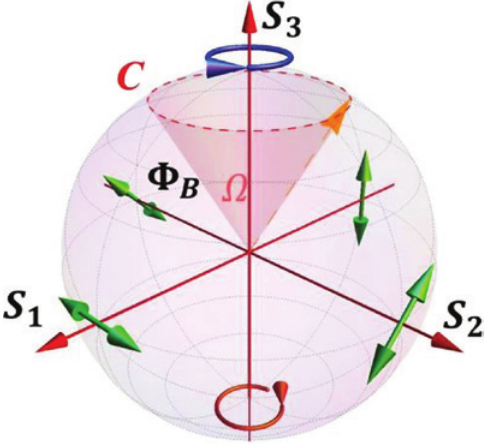
be characterized by the Stokes parameters ( S in general [68]. For a totally polarized beam, these para-